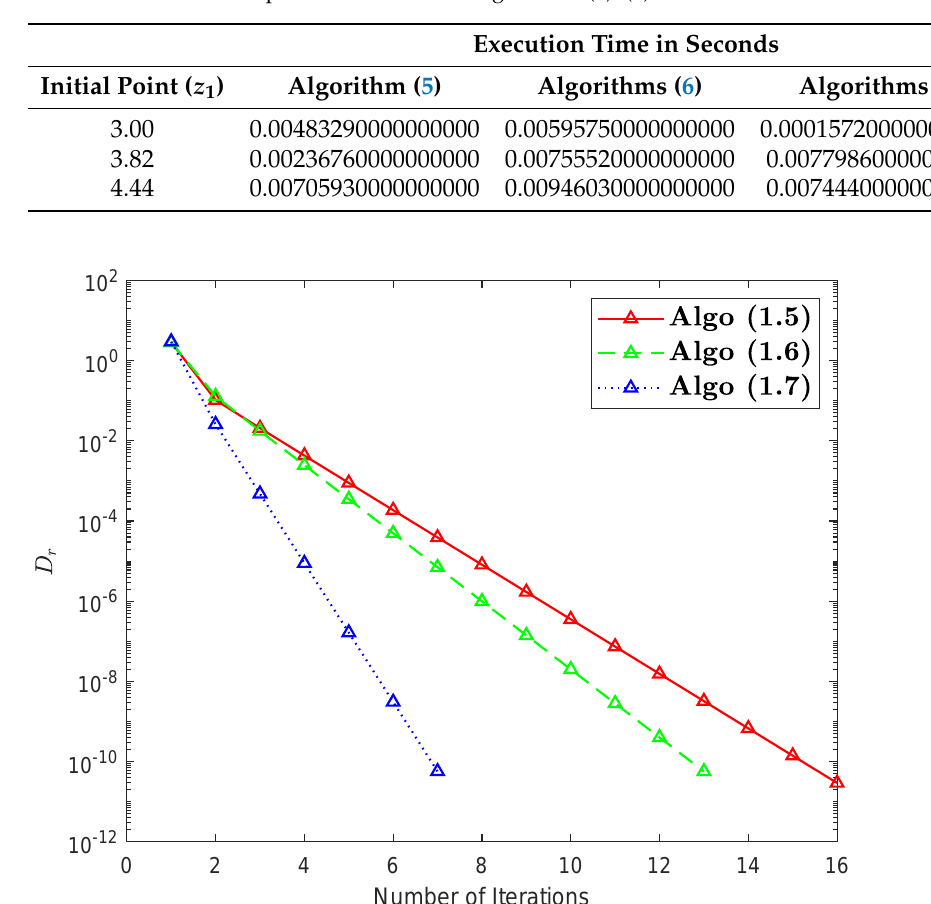
Table 2. Numerical comparison of results of Algorithms (5)–(7).